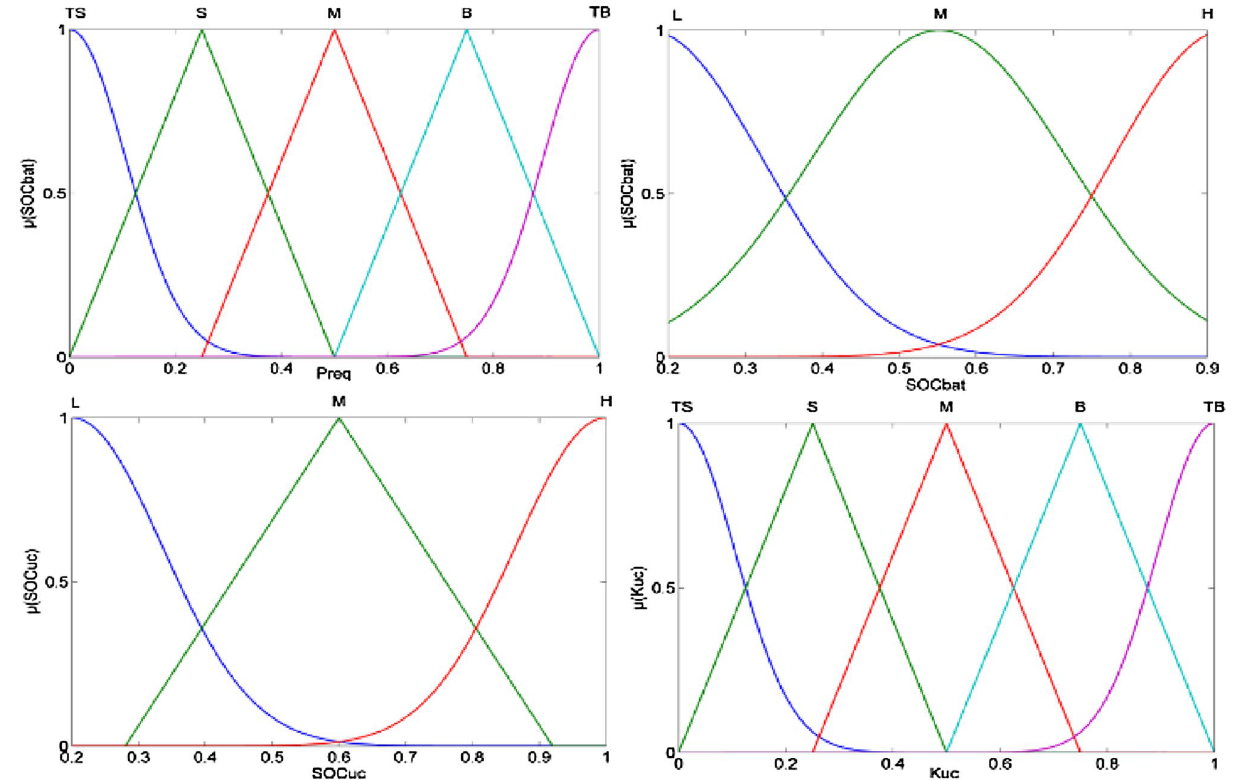
Fig. 7 Input and output membership function of discharge fuzzy controller